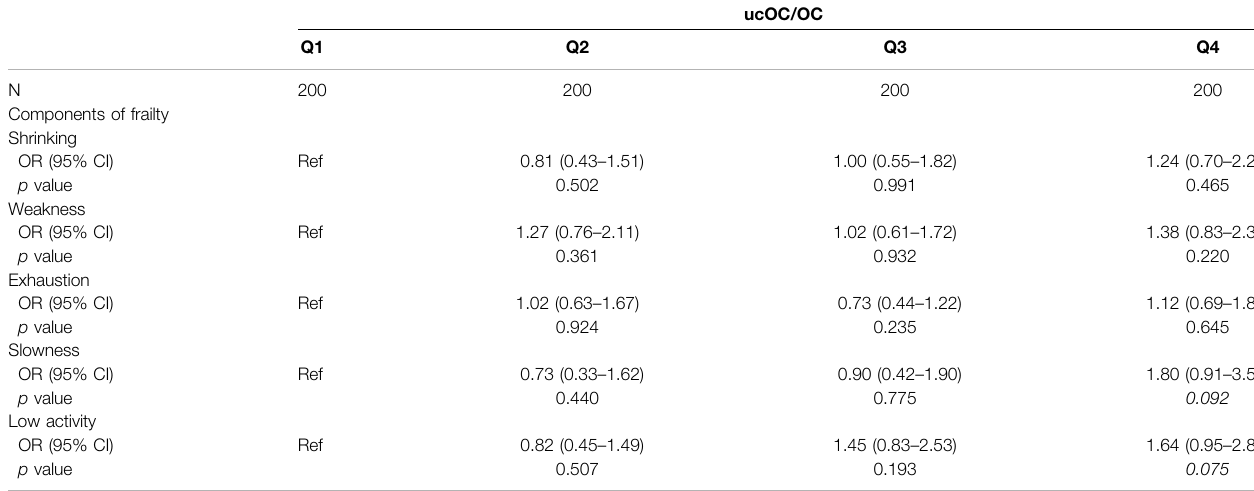
TABLE 3 | Associations between ucOC/OC and components of frailty.